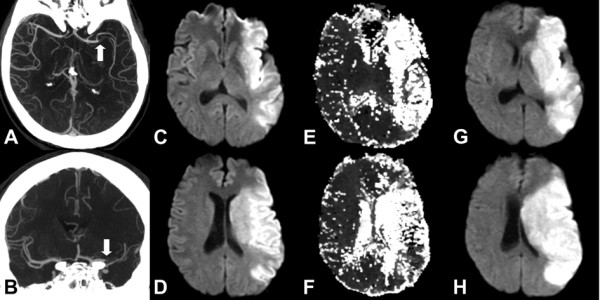
51 year old male presenting to the ED with right hemiparesis and aphasia. Imaging was initiated 4 hours after witnessed symptom onset. A &B. CTA demonstrates occlusion of the proximal left MCA (white arrows). C &D. Initial DWI shows large abnormality of the left MCA territory. E &F. MR perfusion time to peak (TTP) maps demonstrates hypoperfusion of similar extent as the diffusion abnormality. G &H. Follow-up MRI shows no significant enlargement of the initial abnormality. Whole brain map volume measurements for this patient are: DWI: 154 ml; MTT: 211 ml (mismatch: 57 ml); TTP: 241 ml (mismatch 87 ml).